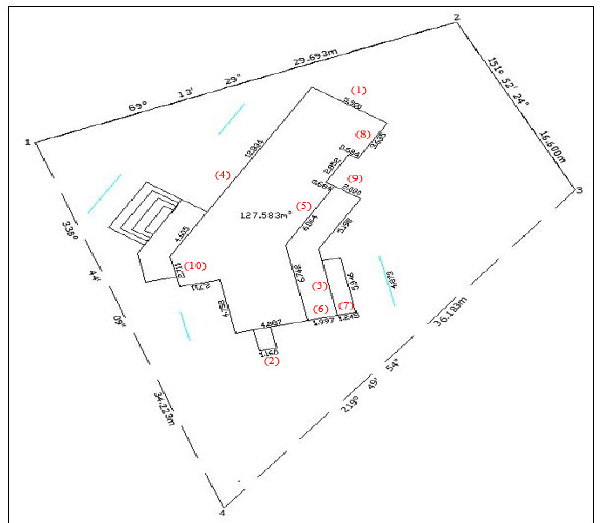
Figure 15. The 2D drawing from field work dimension survey.